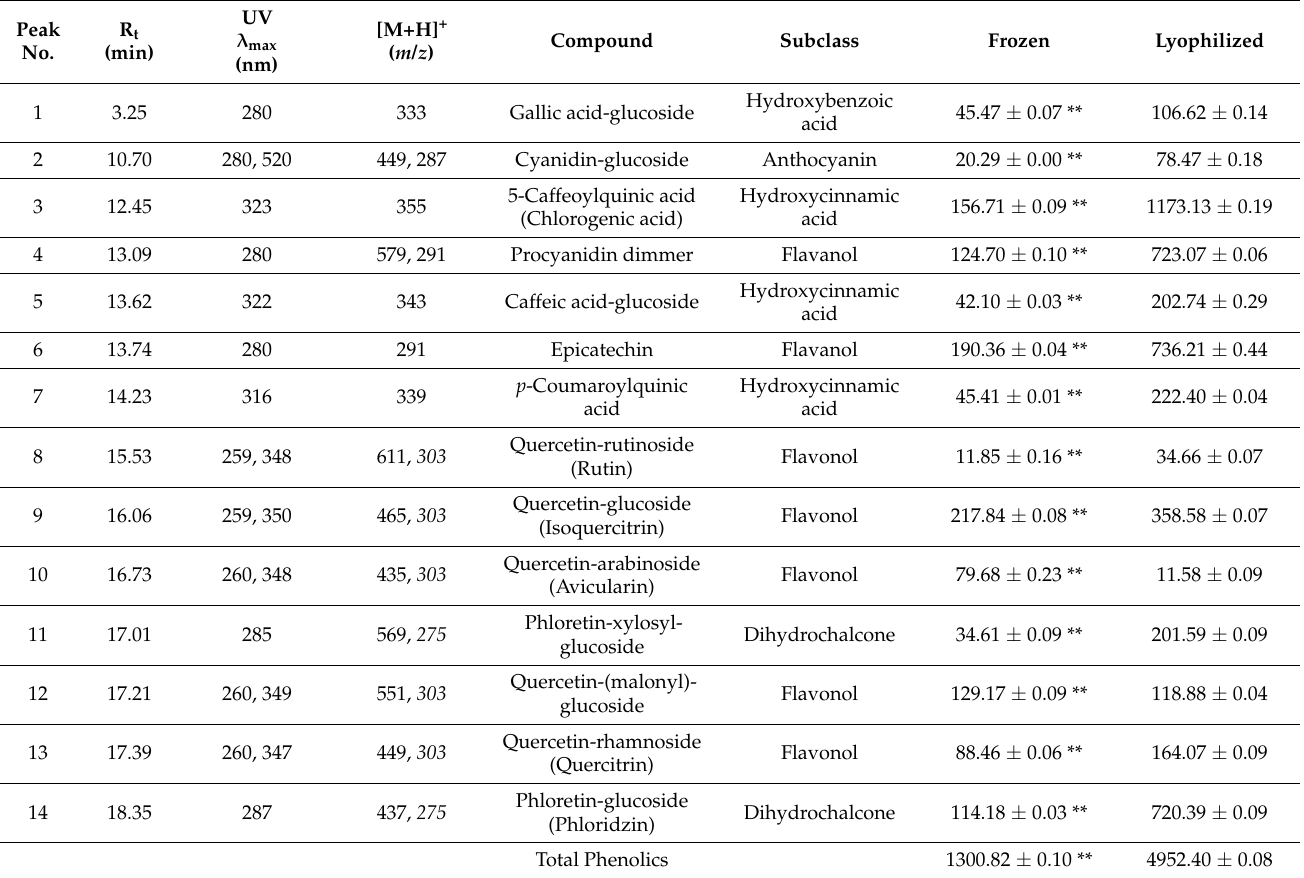
Table 2. Individual phenolic composition of the AP samples, expressed in µ